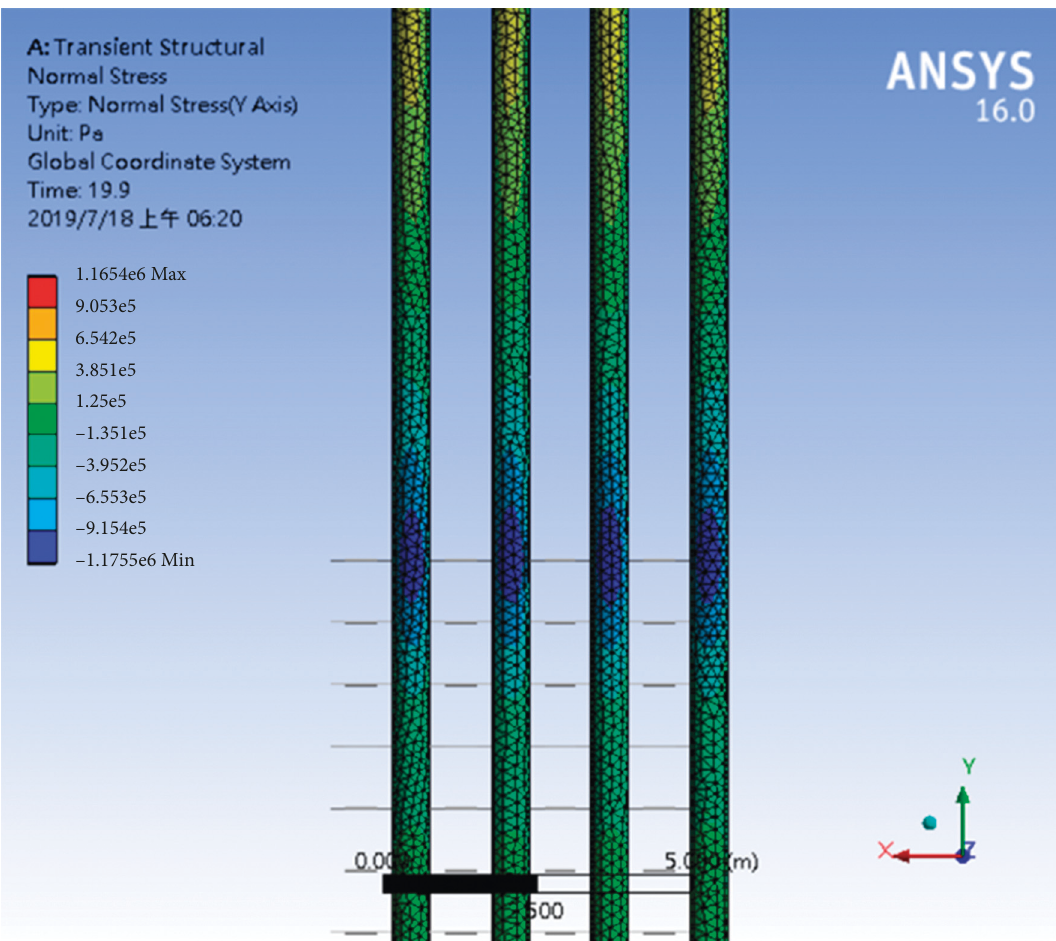
Figure 20: The simulated axial stress distribution on the pile.